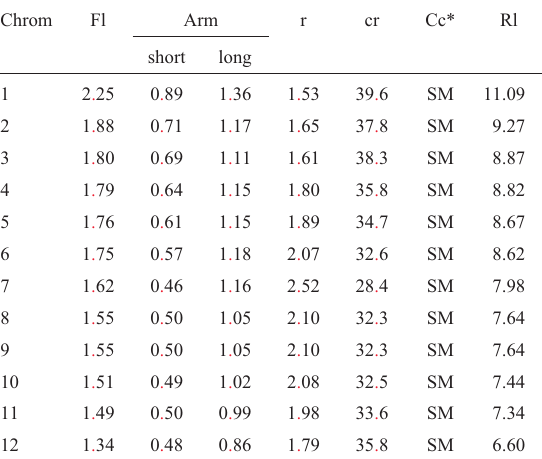
*SM = submetacentric. Chrom: Chromosome. Fl: Full length ( (cid:1) m). r: Ratio between arms. cr: Centromeric rate. Cc: Chromosome class. rl: Relative length